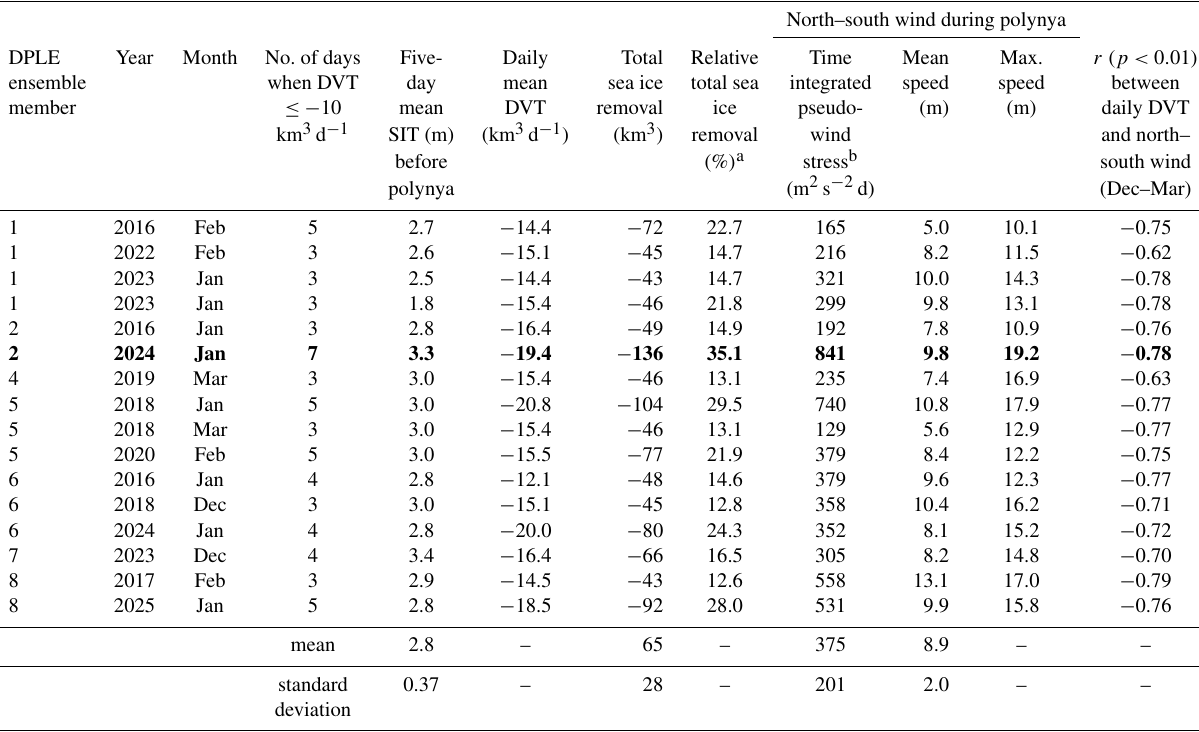
Table 4. Same as Table 3 but for the RASM–DPLE simulation, initialized on 1 December 2015.